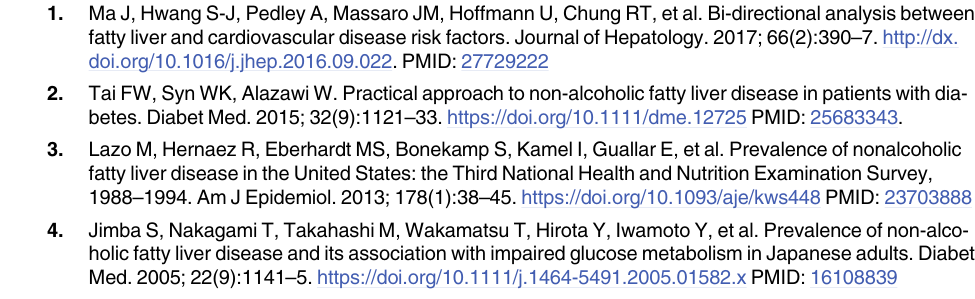
S1 Table. Models for the association between periodontal pathogen clusters and steatosis (n = 3236). S2 Table. Characteristics of patients recruited in prospective (London)